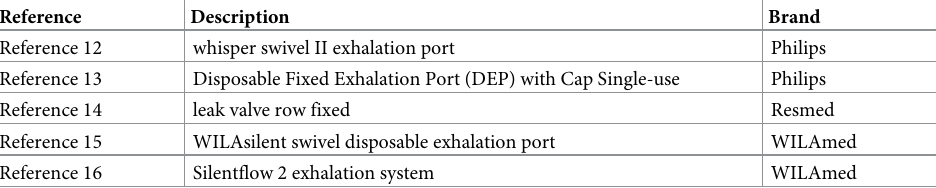
Table 2. Industrial leak valves used as controls. Rendering adapted from images provided by the